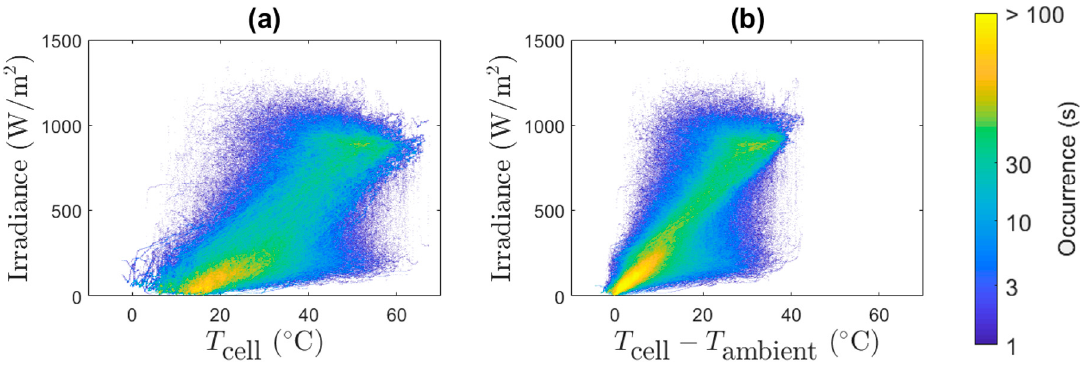
Figure 5. Occurrence of ( a ) irradiance and PV cell temperature T cell , and ( b ) irradiance and the difference between T cell and the ambient temperature T ambient during the observation period in one PV panel.